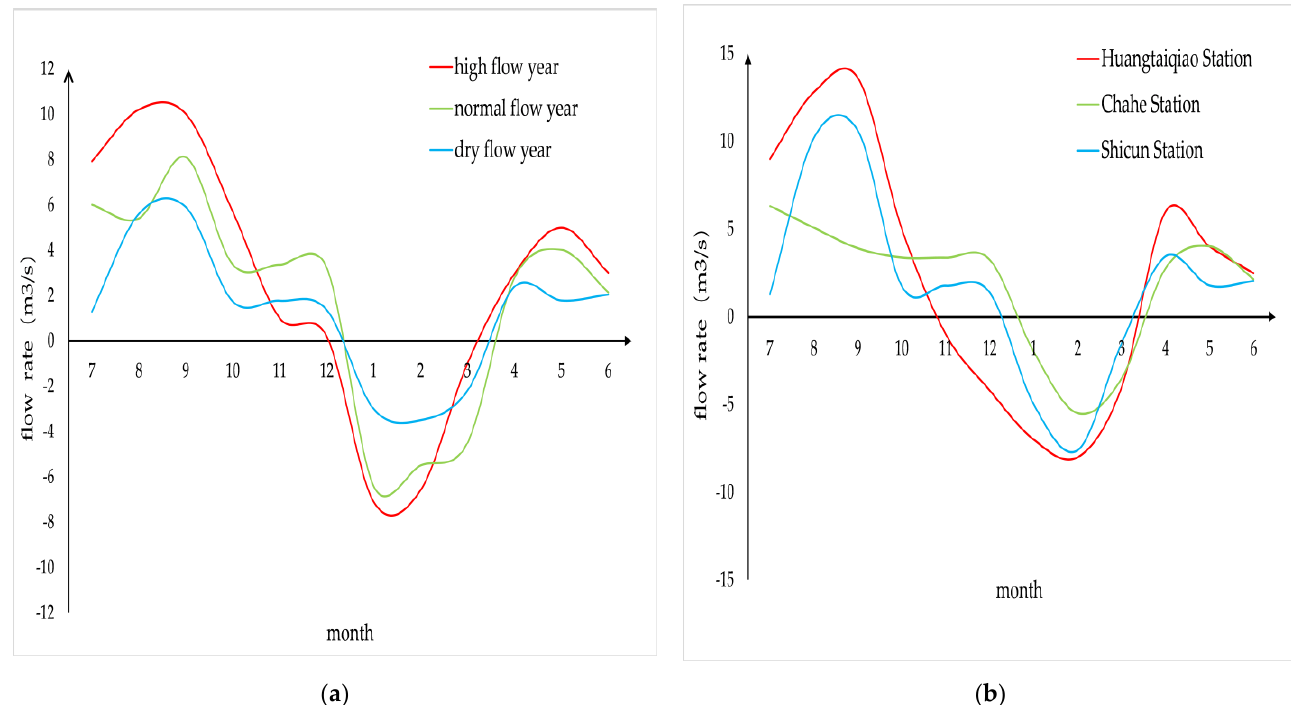
Figure 7. Simulation results of monthly discharge at hydrological stations: ( a ) Change in exchange capacity in Jinan section during abundant and dry season; and ( b ) change in exchange capacity in the upper, middle, and lower reaches of Xiaoqing River basin. Huangtaiqiao Station, Chahe Station, and Shicun Station are in the upper, middle, and lower reaches of the basin, respectively.